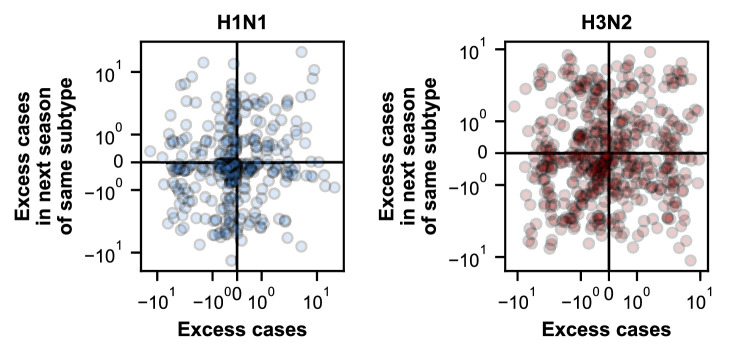
Correlation of excess cases between seasons.We tested whether excess cases in each birth cohort were negatively correlated with excess cases in the same birth cohort in the next season of the same subtype (Appendix 1: ‘Calculating excess cases’). We find a weak positive correlation for cases of H1N1 (Spearman’s ρ=0.12, 95% CI 0.02–0.22) and H3N2 (Spearman’s ρ=0.05, 95% CI −0.03–0.14).